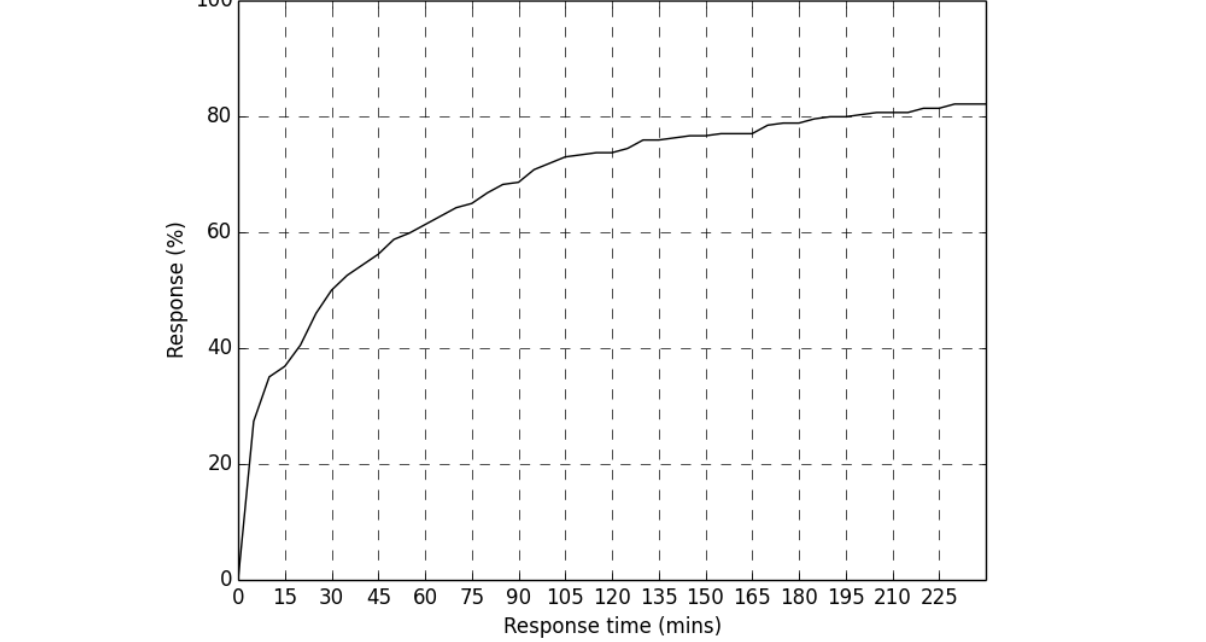
Figure 2. Cumulative distribution function of response times of opening app after geofence support notifications were